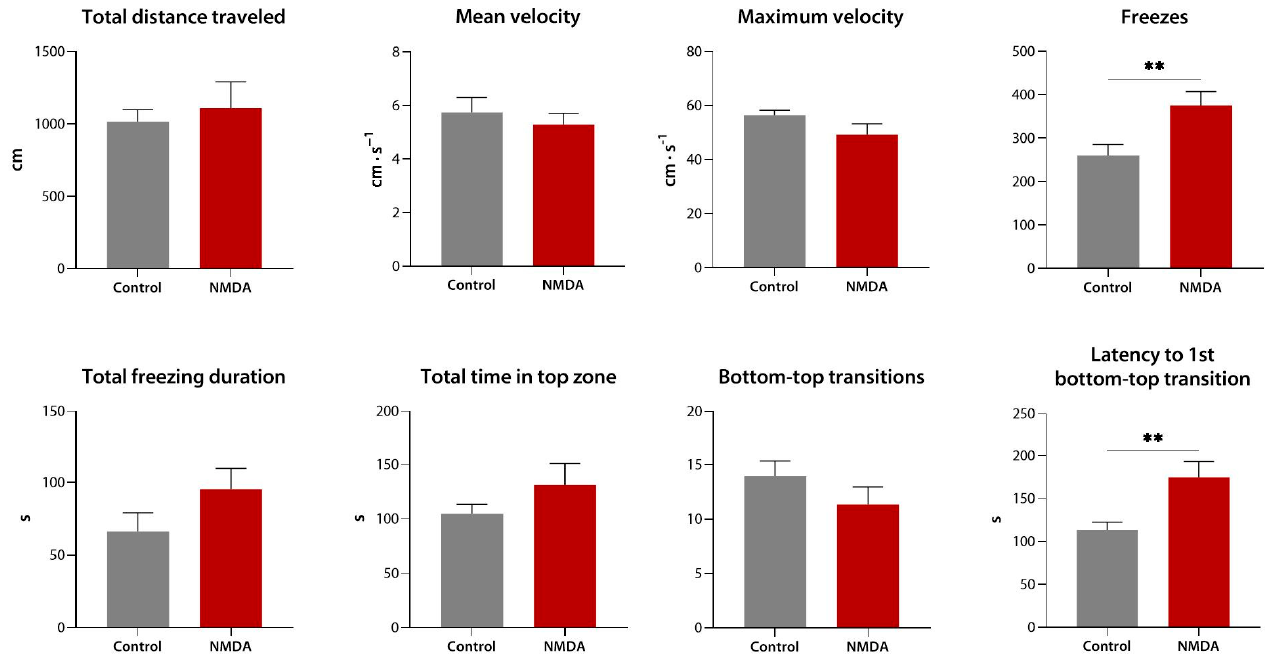
Figure 8. N-methyl-D-aspartate (NMDA) at 100 mg · L − 1 does not induce a psychostimulant-like effect in zebrafish, as assessed using the novel tank test. **, p < 0.01.